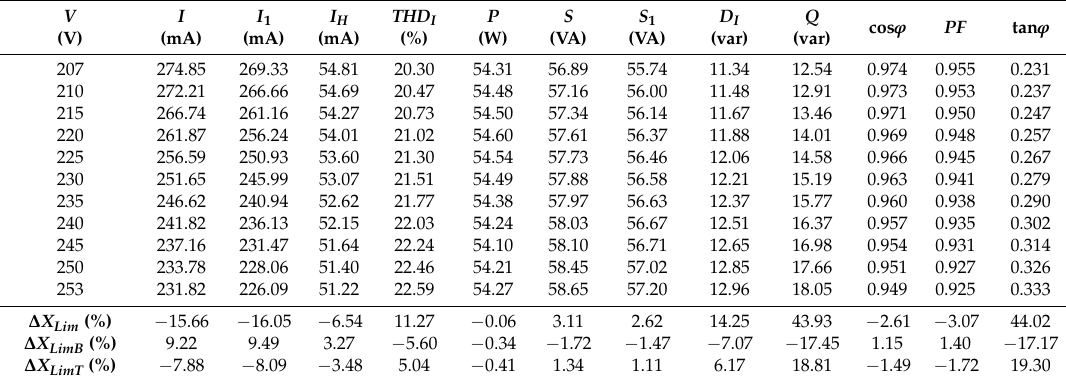
Table 4. Summary of the measured values of the electrical parameters of the lighting luminaires marked as